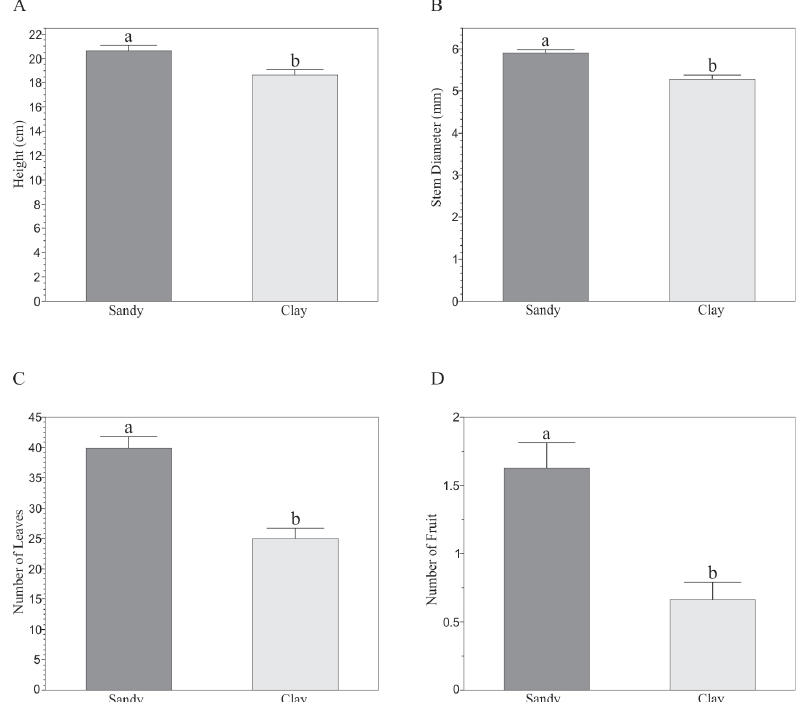
Figure 3. Results of morphological variables of chili pepper plants grown in sandy and clay soils. Comparison of means ± S.E. by using Tukey ′ s test for the morphological variables that were assessed in sandy and clay soils. ( A ) Height; ( B ) Stem diameter; ( C ) Number of leaves; ( D ) Number of fruit. In all cases, p = 0.05.